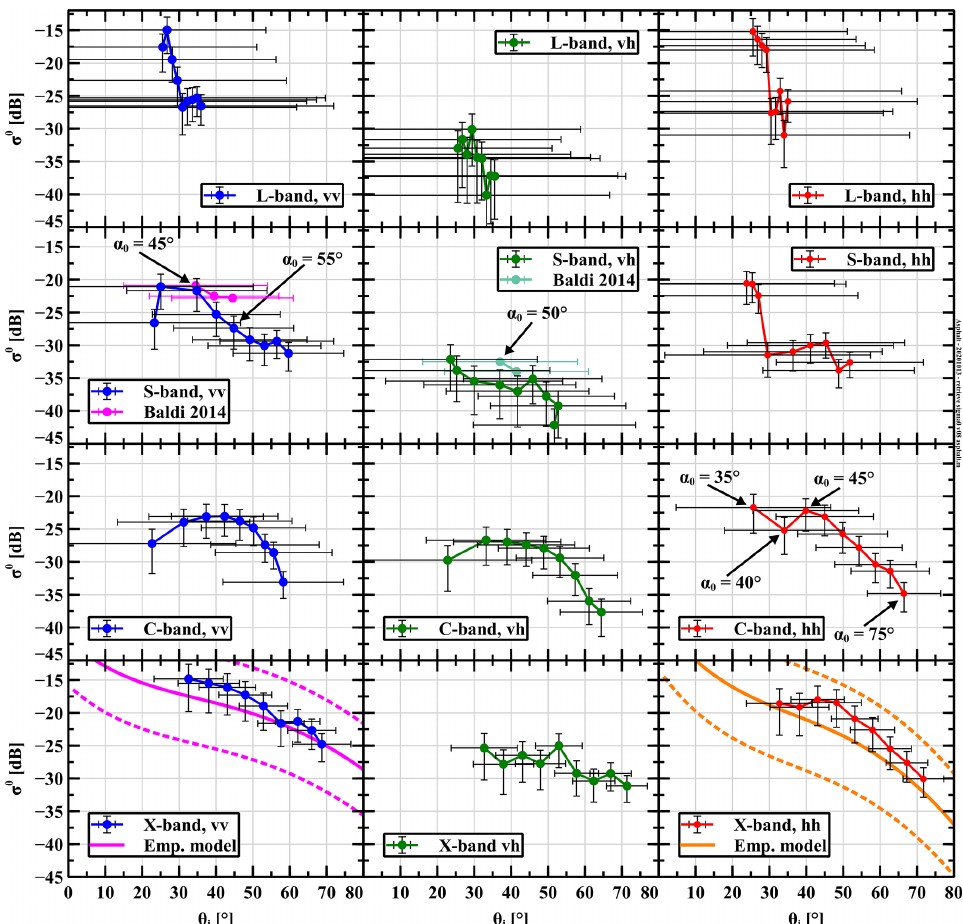
Figure F1. Measurement results of σ 0 pq ( α 0 ) for all bands and polarizations together with S-band measurement results from Baldi (2014) and empirical model for X-band from Ulaby and Dobson (1989). Points represent results for different antenna boresight angles α 0 . Horizontal bars represent intervals for angle of incidence θ , and vertical bars represent the 66% confidence interval for σ 0 . Dotted lines between data points serve as guides. With X-band, solid and dotted curves (magenta and orange) represent the mean value and 90% confidence interval of the empirical model